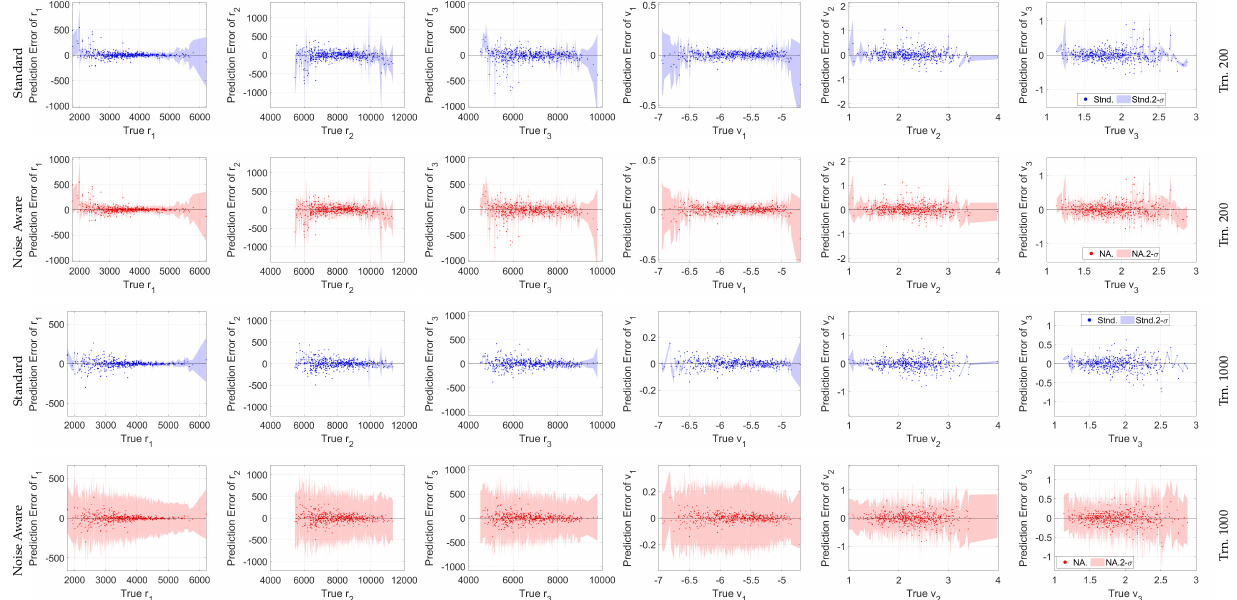
Figure 13. Cartesian state versus the GPR output error with accompanying 3- σ bounds for a 500 point random sub-sample of the 25,000 total samples. Note the different y -axis scales between the training levels.